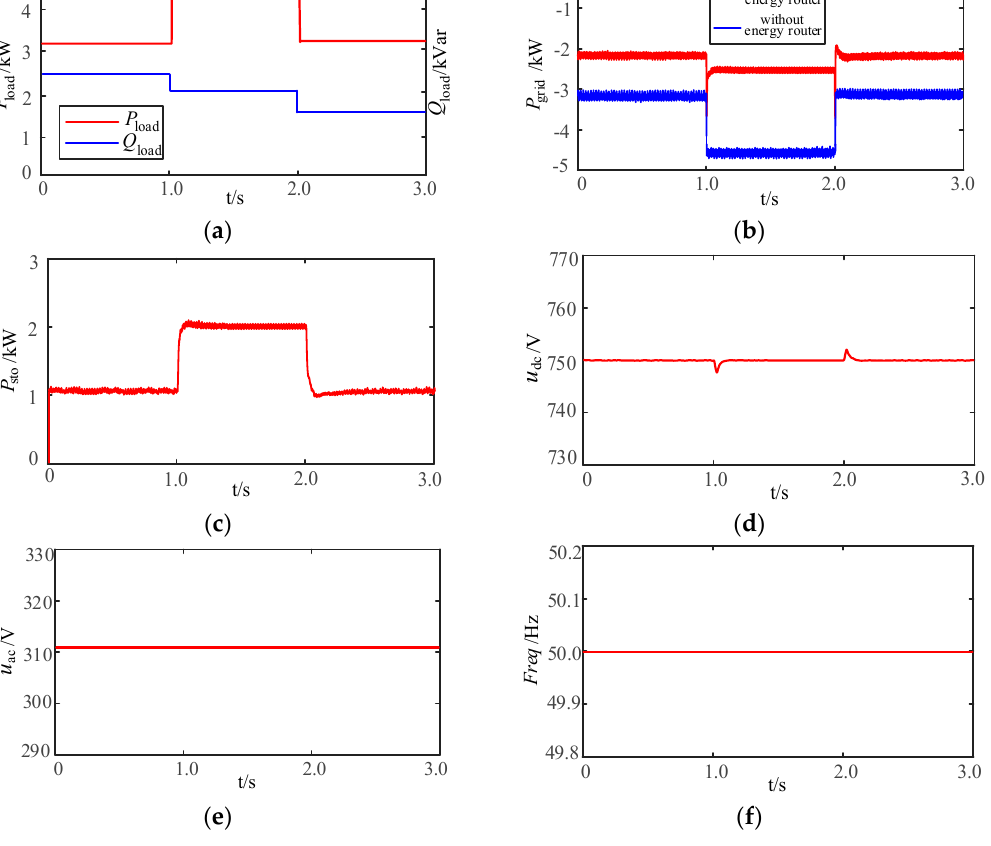
Figure 15. Simulation results of energy router in case 3: ( a ) Load consumptions; ( b ) The active power imported from the distribution network with or without energy router; ( c ) Total charging or discharging power of the self-energy storage system; ( d ) DC bus voltage; ( e ) AC bus phase voltage; ( f ) AC bus frequency.